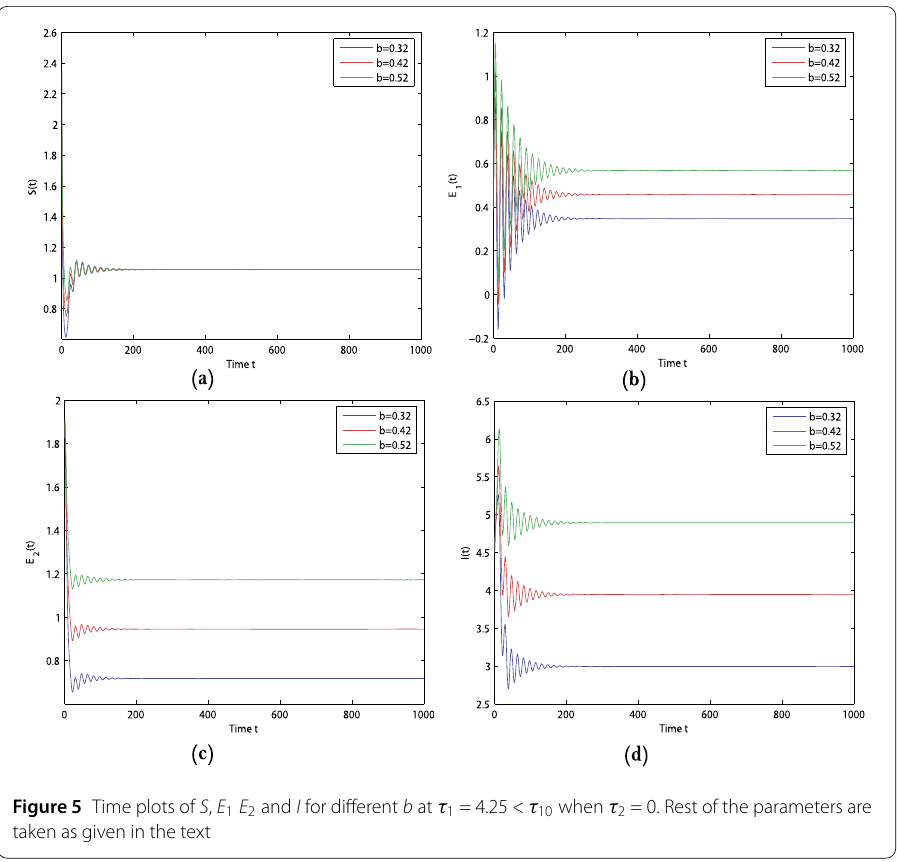
Figure 6 Dynamic behavior of system (26): projection on S – E 1 – I with τ 1 = 4.75 < τ 10 when τ 2 = 0 for different b . Rest of the parameters are taken as given in the